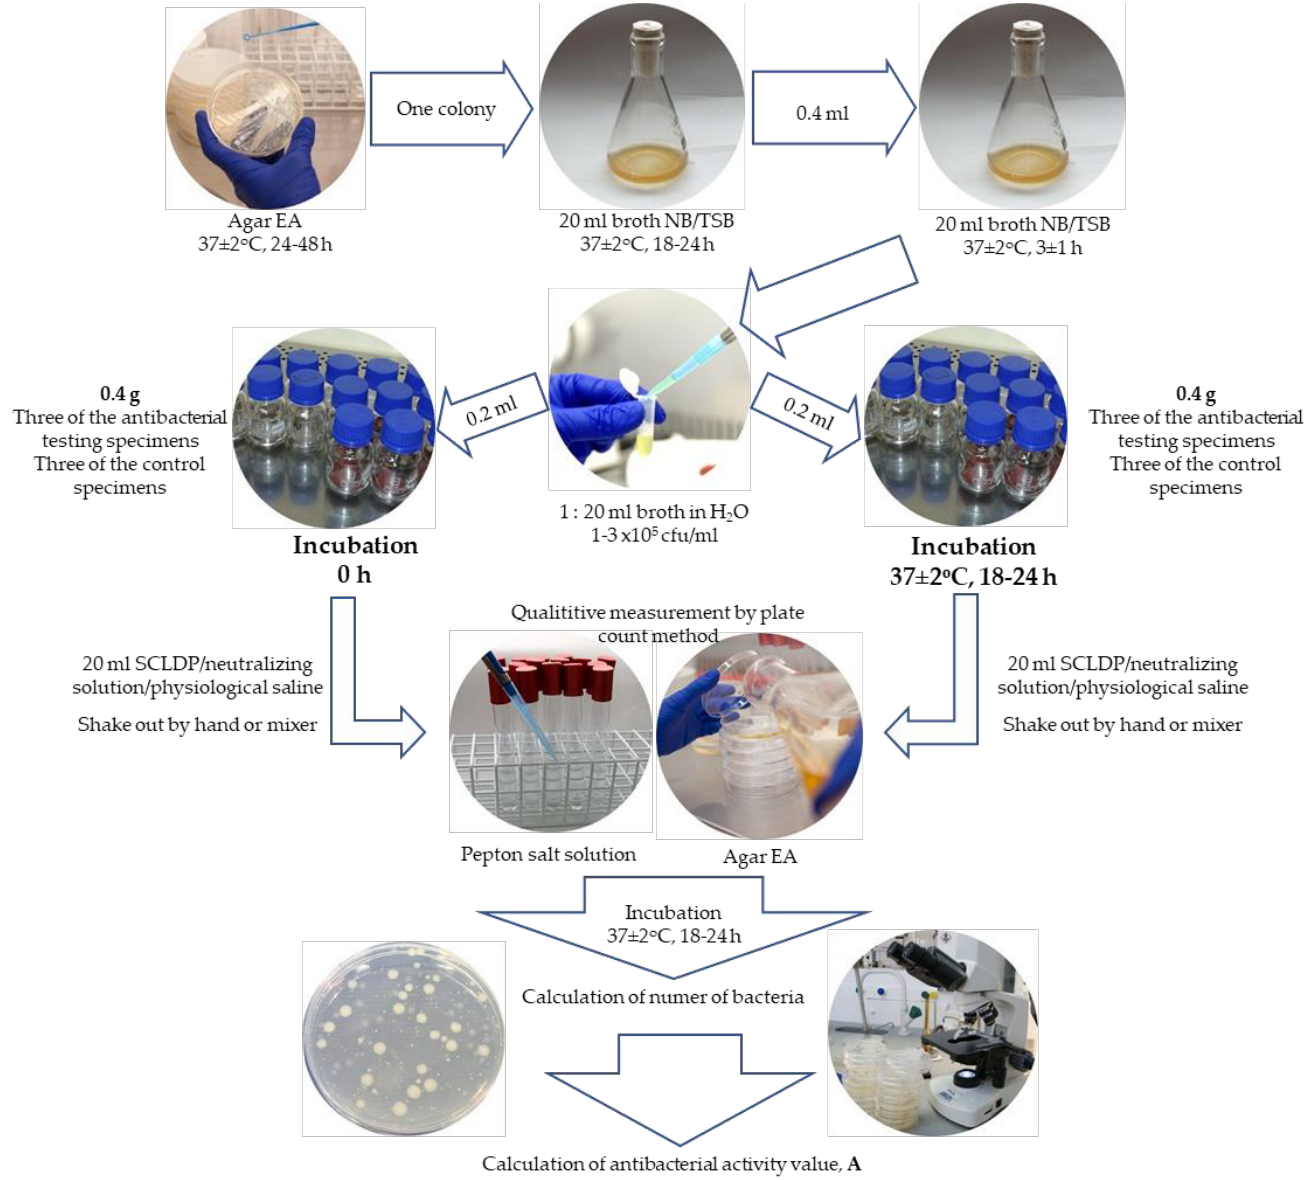
Figure 7. Scheme of the test according to the PN-EN ISO 20743 absorption method.